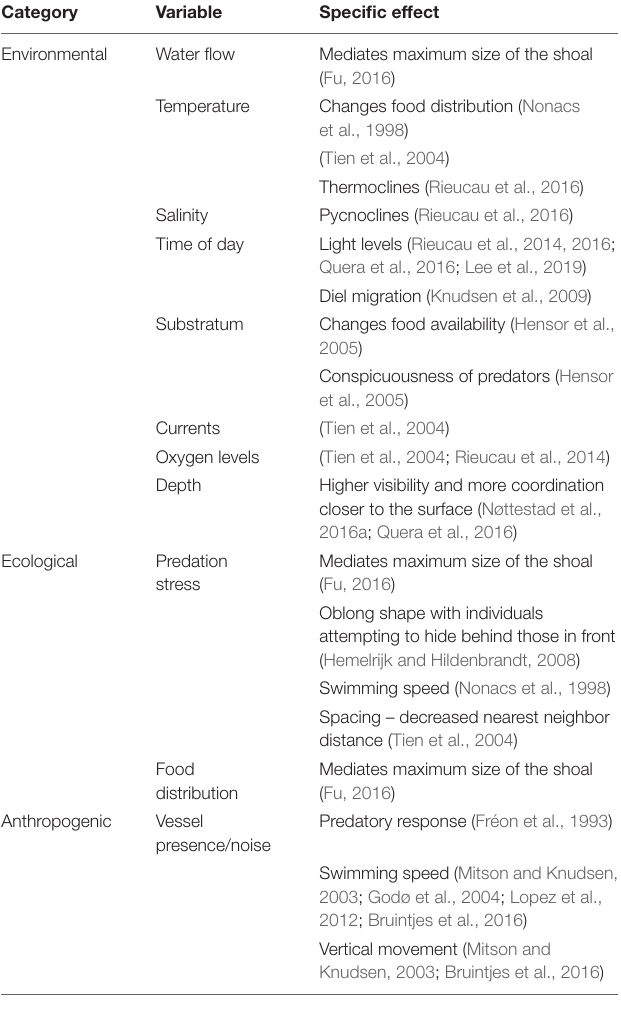
TABLE 2 | Intrinsic sources of variability in individual behavior that may affect the overall shape and density of a shoal and therefore acoustic measurements, where they are mentioned in the literature, and the specific effects of these variables, if